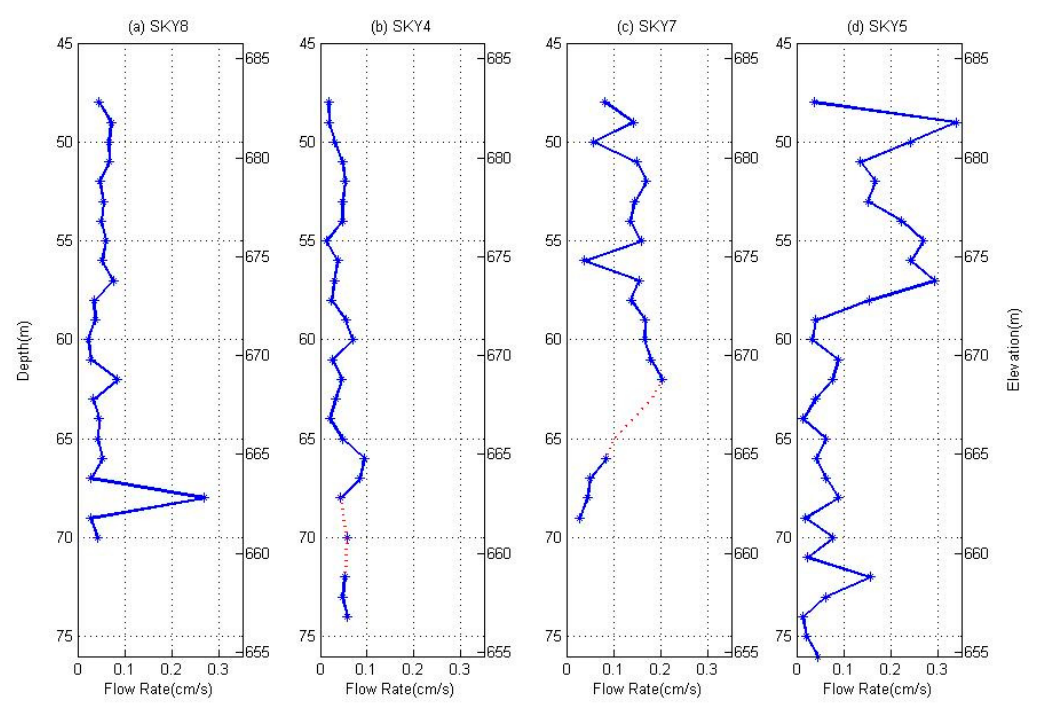
Figure 8. Water flow chart for SYK8 ( a ), SYK4 ( b ), SYK7 ( c ) and SYK5 ( d